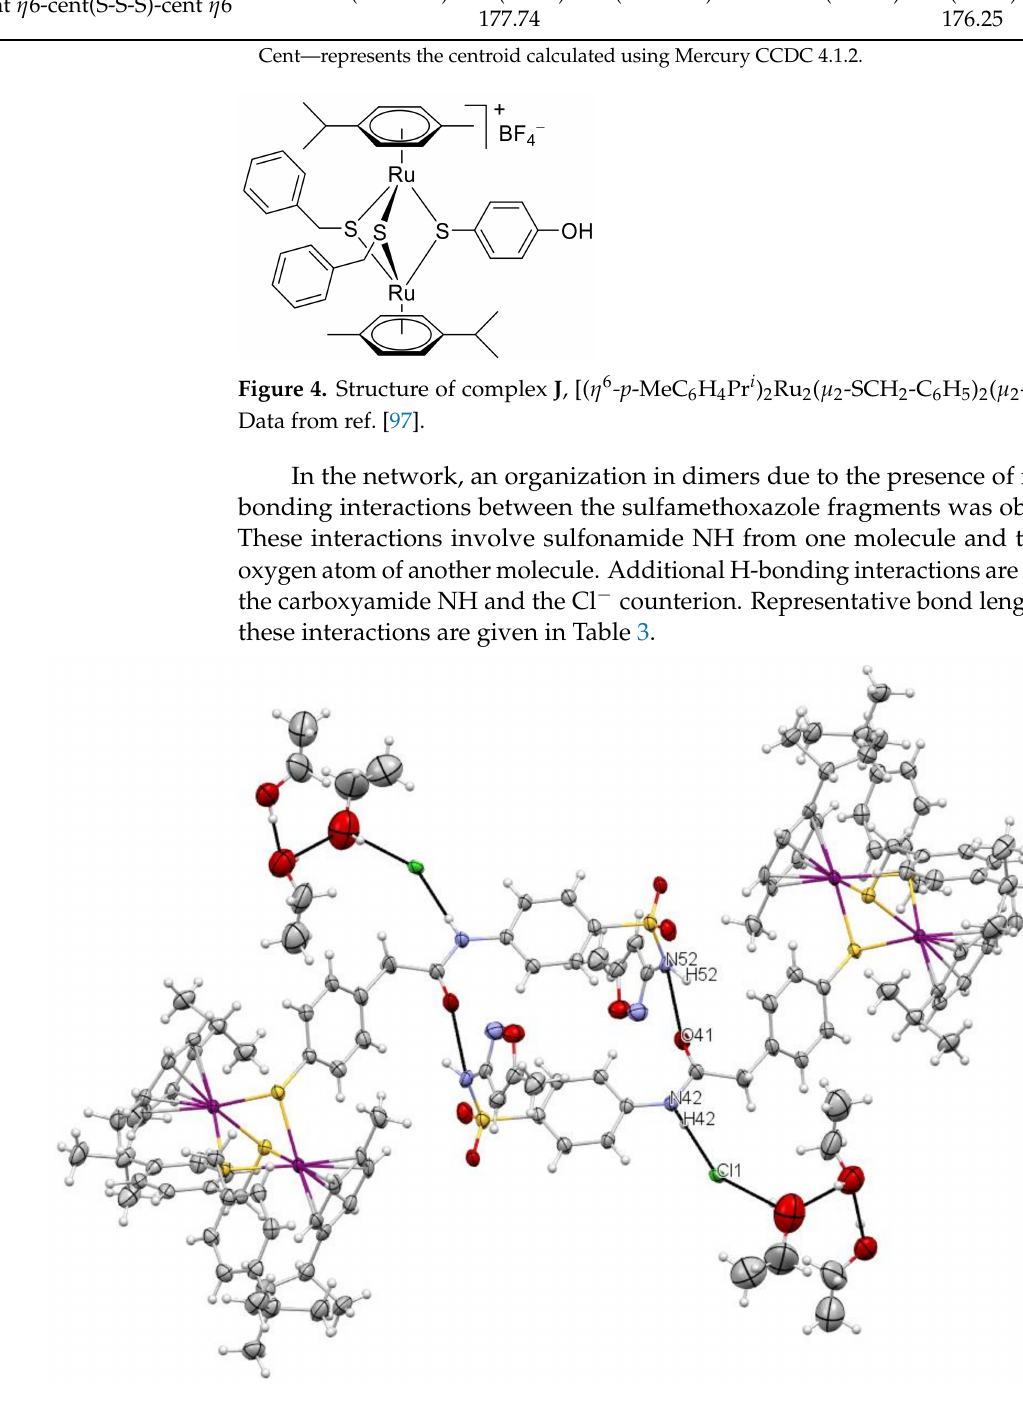
Figure 5. Intermolecular H-bonding interactions in the crystal of 9 with the formation of dimers; two H-bonds interconnect the carboxyamide C=O groups from the two diruthenium complexes to the sulfonamide NH from the other molecule. Supplementary H-bonding interactions were observed between the carboxyamide NH and the Cl − counterion (contacts D-H · · · A correspond to N-H · · · Cl − , N-H · · · O, image produced using Mercury CCDC 4.1.2, see bond parameters in Table